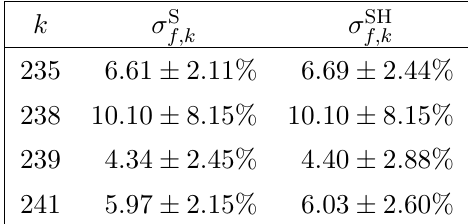
Table 2 . Cross sections per (cid:12)ssion of the four (cid:12)ssionable isotopes calculated by the Saclay (S) group ( (cid:27) S ) in ref. [8] and those obtained from the Huber (SH) correction ( (cid:27) SH f;k units are 10 (cid:0) 43 cm 2 = (cid:12)ssion. The index k = 235 ; 238 ; 239 ; 241 indicates the four isotopes 235 U, 238 U, 239 Pu, and 241